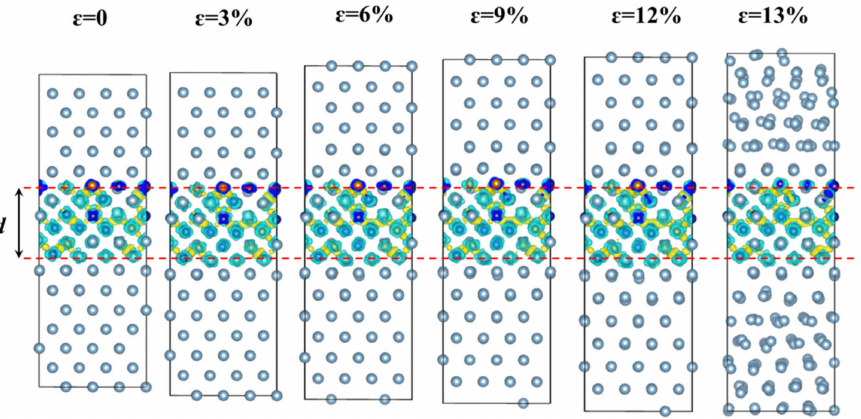
Figure 8. The evolution of atomic structure of HEA-reinforced AMC under various tensile strains applied along [001]